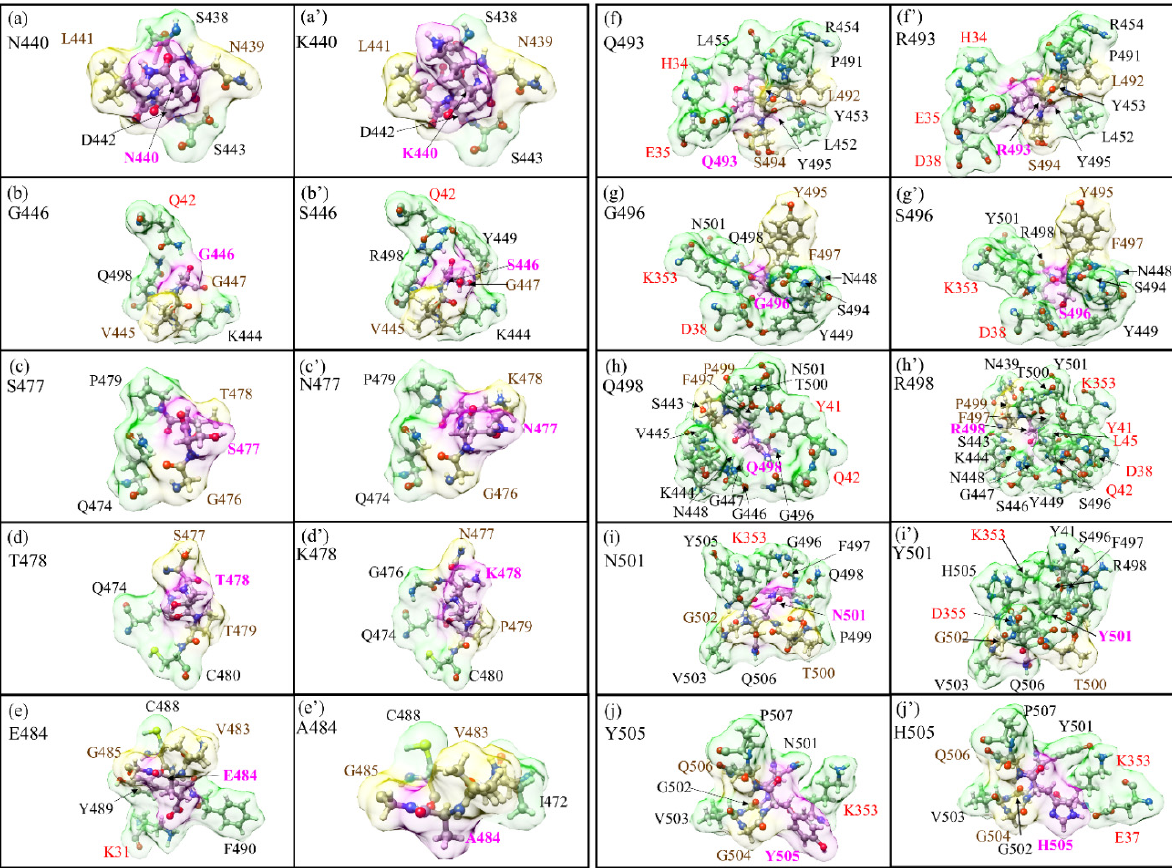
( c ) S477, ( d ) T478, ( e ) E484, ( f ) Q493, ( g ) G496, ( h ) Q498, ( i ) N501, and ( j ) Y505 for the WT. ( a (cid:48) ) K440,